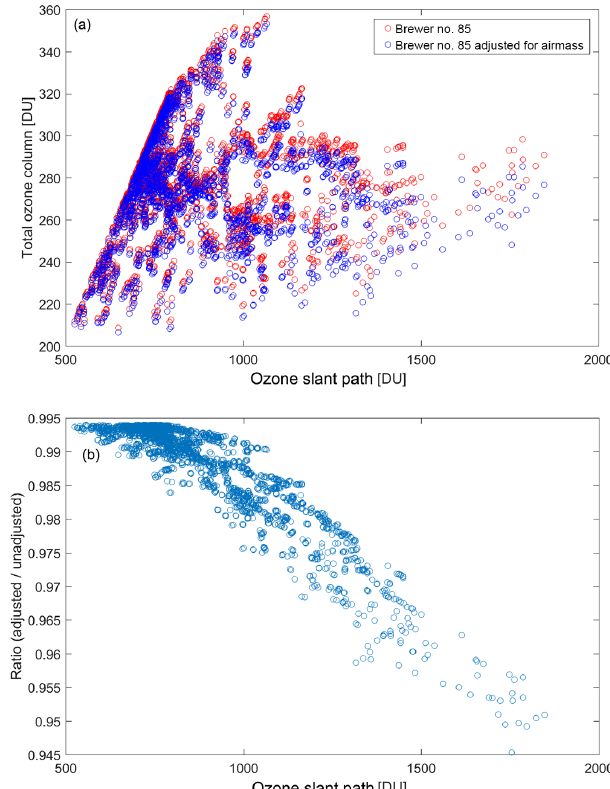
Figure 8. (a) Total ozone column values larger than 220DU mea- sured by double Brewer no. 085 versus total ozone slant path. Total ozone columns calculated using adjusted air masses are also shown (see the details in the text). (b) Ratio of total ozone column retrieved using adjusted air mass to total ozone retrieved using unadjusted air